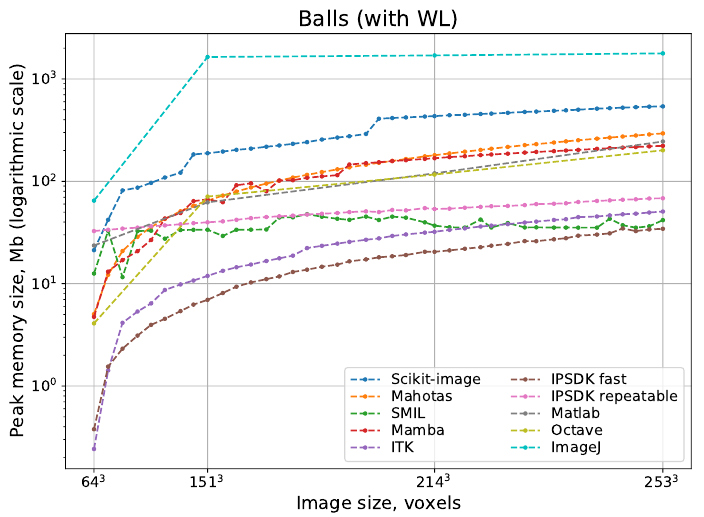
Figure 13. Peak memory consumption for watershed with WL depending on 3D image size.